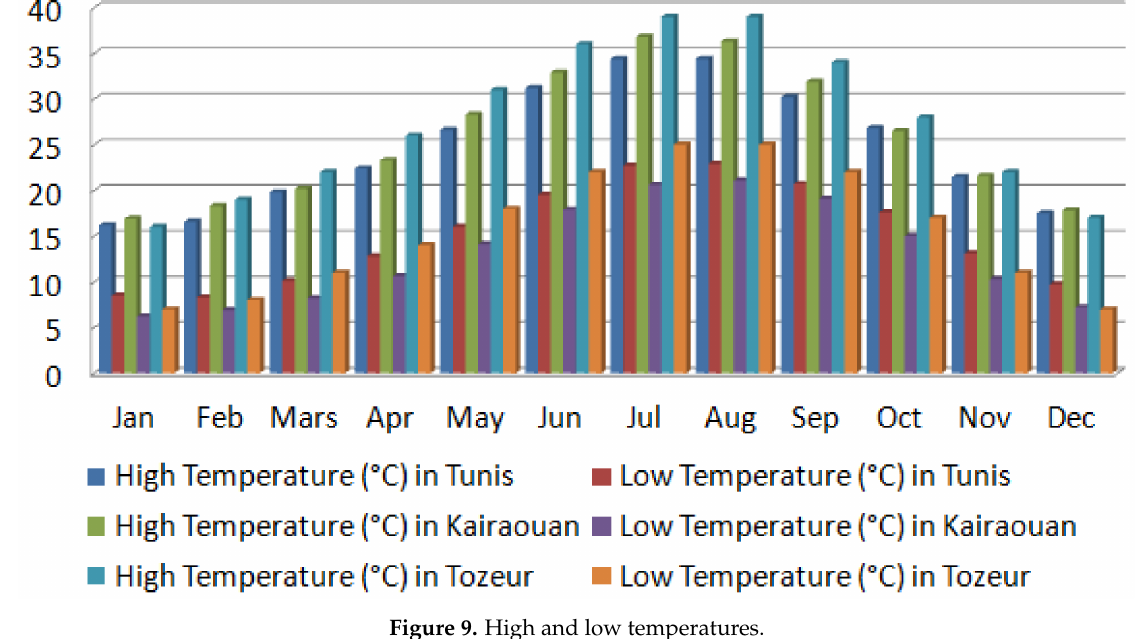
Figure 9. High and low temperatures.